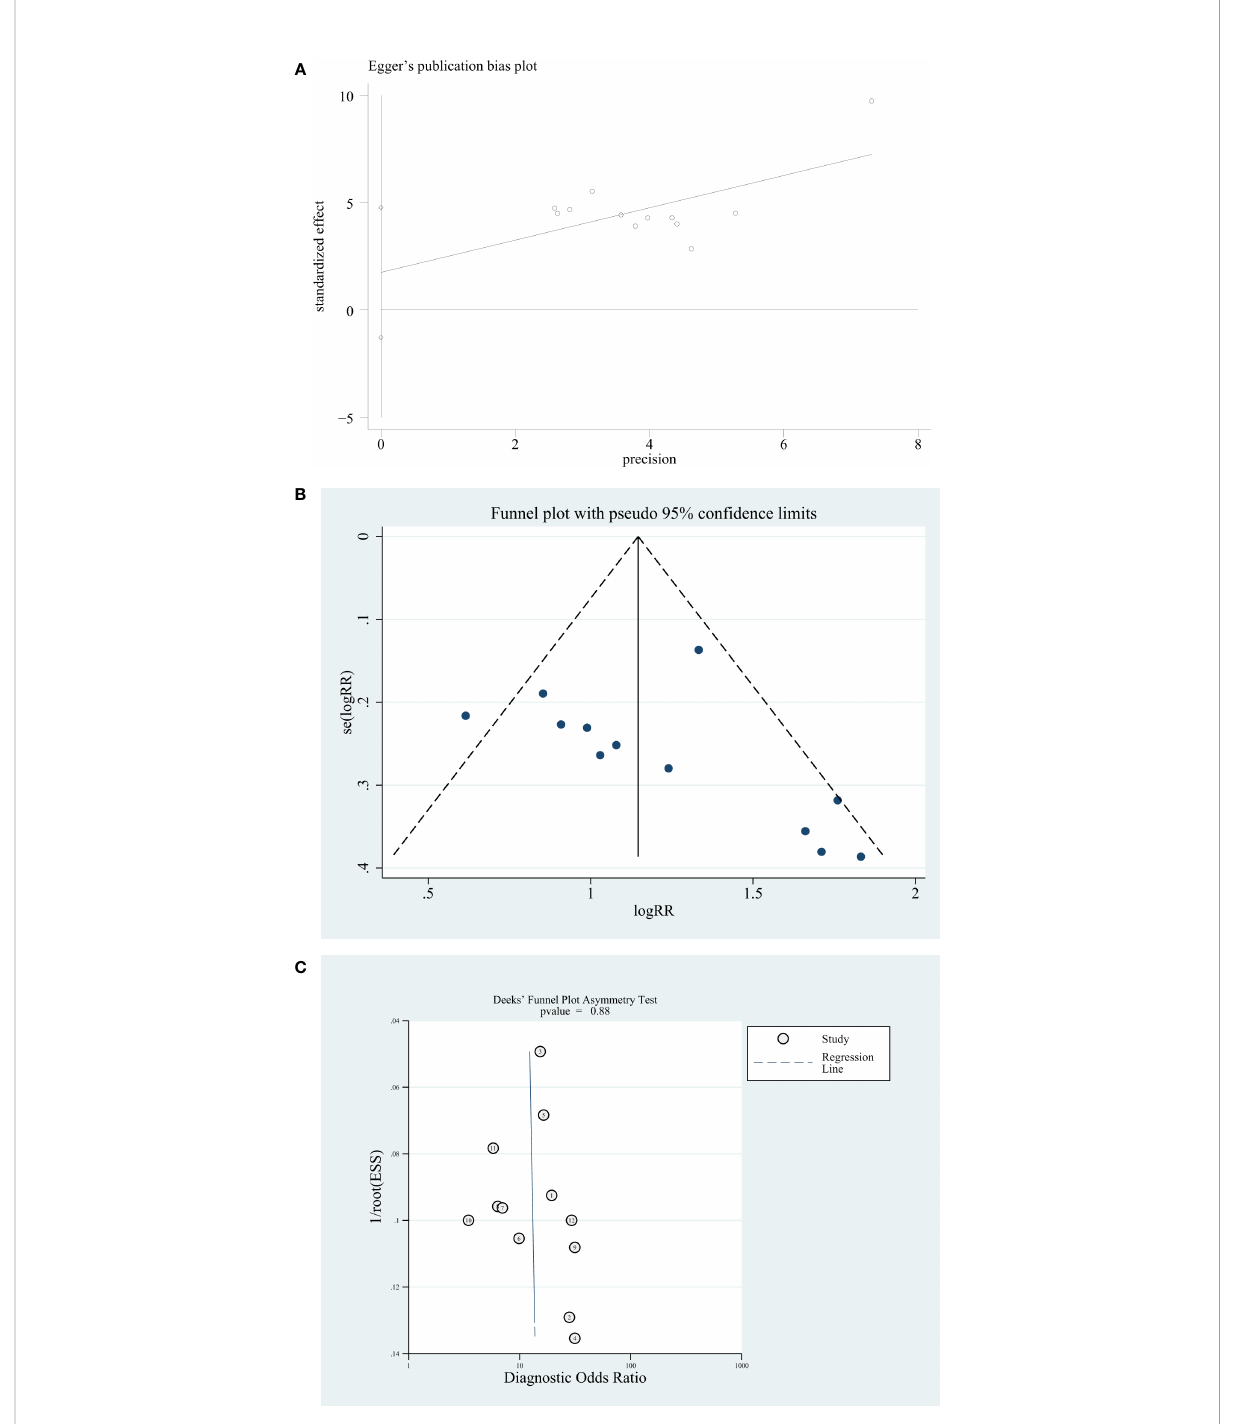
FIGURE 4 Publication bias analysis. (A) Egger ’ s publication bias plot. (B) Funnel plot. (C) Deeks ’ funnel